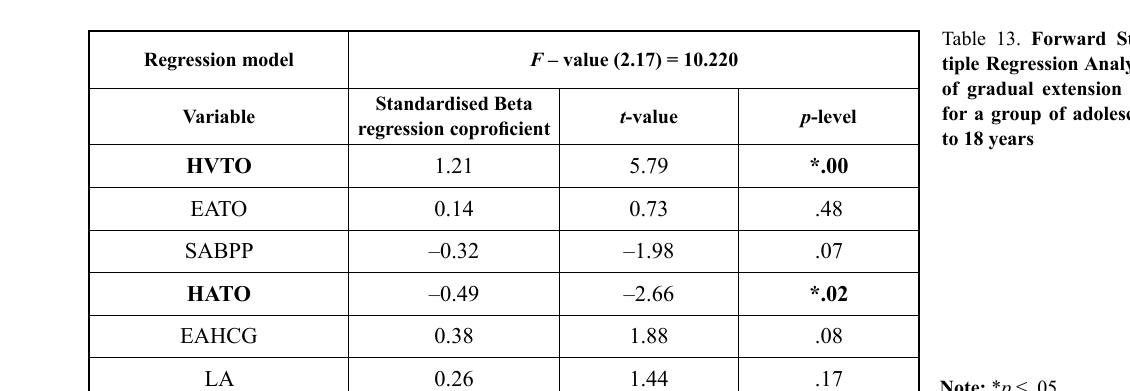
Table 12. Backward Stepwise Multi -